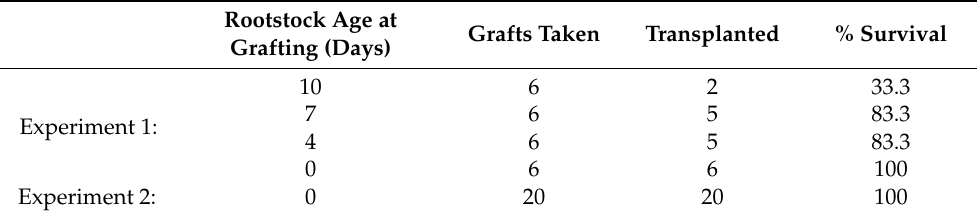
Table 2. Survival of CBD1 scions grafted to THC7 rootstocks of different ages. Rootstock Age at Grafts Grafting (Days)